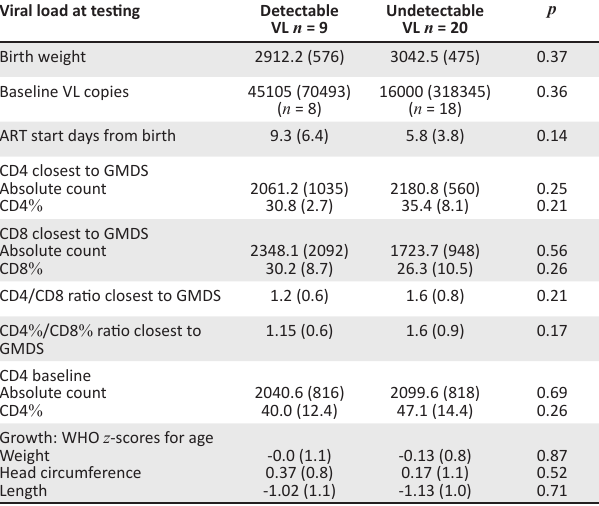
TABLE 2-A1: Comparison of participant characteristics for those who had detectable and undetectable viral loads at Griffiths mental development scales testing reported as mean (standard deviation).